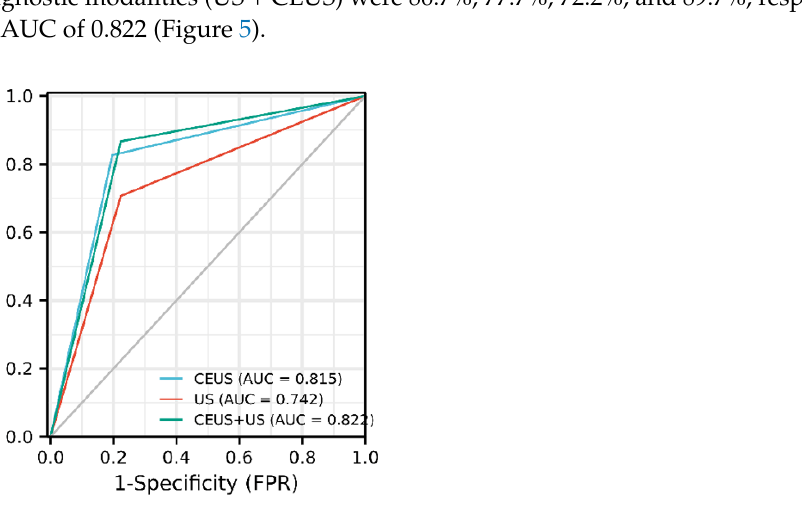
Figure 5. Receiver-operating characteristic (ROC) curves for US, CEUS, and CEUS + US (US = ultra- Figure 5. sound, CEUS = contrast-enhanced ultrasound).